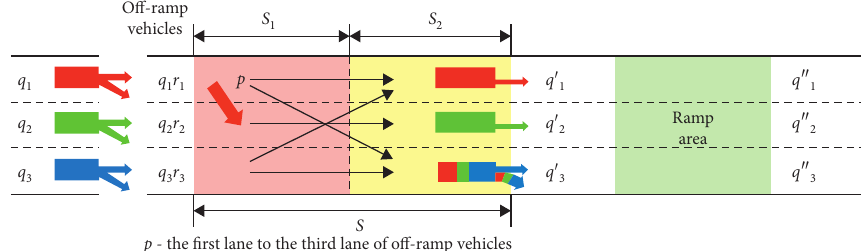
Figure 1: Vehicle group lane-changing behaviors in the upstream section in a ramp